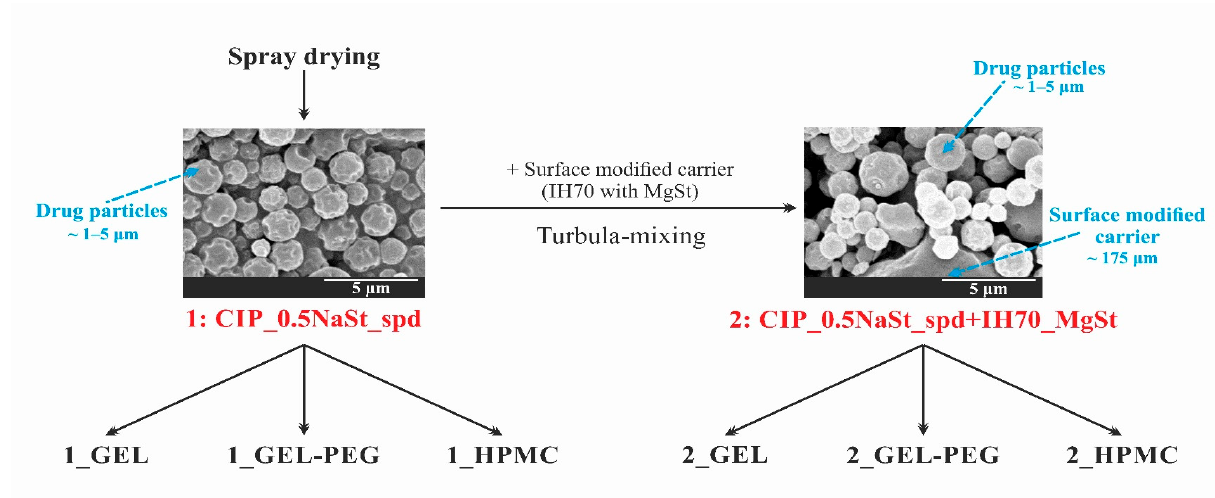
Figure 1. Schematic overview of the preparation. Table 1. Details of the components of the